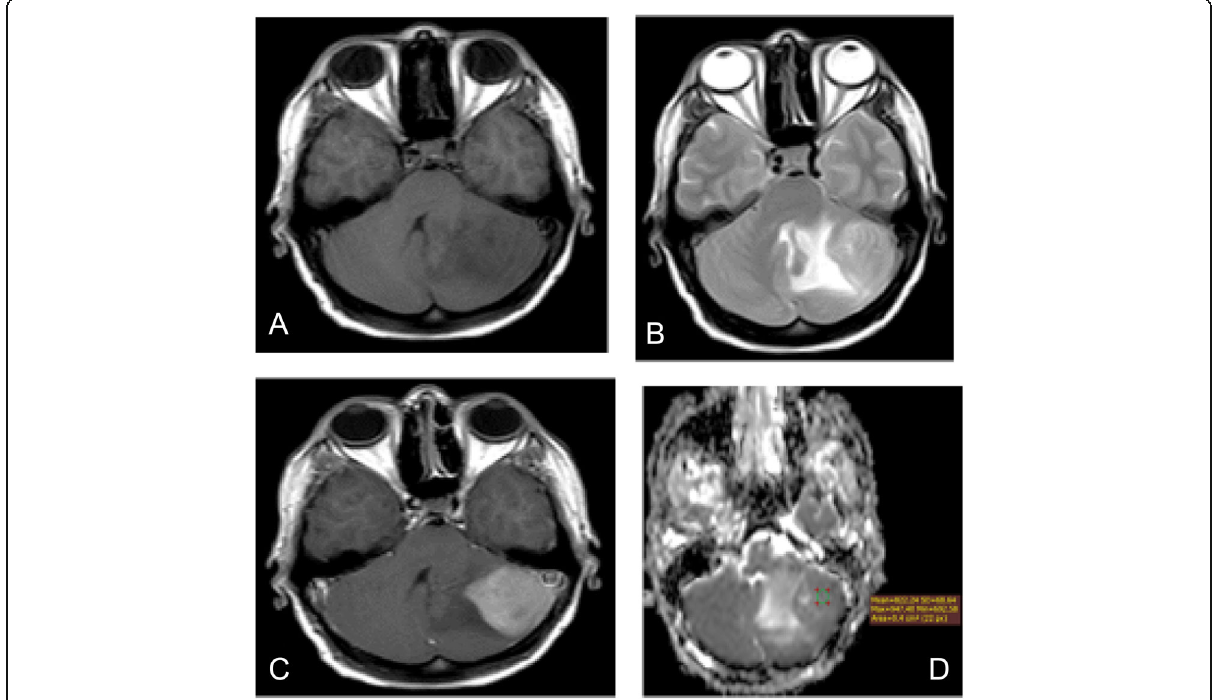
Fig. 4 Typical cerebellar (infratentorial) meningioma in female patient aged 44 years old presented with chronic headache and dizziness 4 months ago. An extra-axial space-occupying lesion (SOL) is seen in the left cerebellar hemisphere lying below and contacting the tentorium cerebelli with moderate perifocal edema, effacement of related cerebellar folia, compression of the fourth ventricle, and minimal rightward shift of midline structures. This mass displays relatively iso to low signal intensity (SI) on T1WI ( a ), iso SI on T2 WI ( b ). It shows homogeneous enhancement on post-contrast T1WI ( c ). It has iso SI-like brain parenchyma on apparent diffusion coefficient images (ADC) map ( d